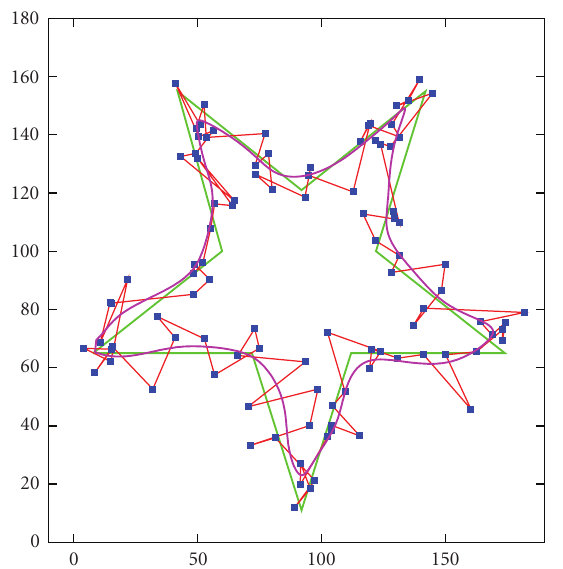
Figure 8: Recovery of the boundary of the star specified by 100 points with Gaussian noise of ν = 16. In this case, an extremely large amount of noise is added, however the algorithm is e ff ective at recovering features of the star shape. The boundary is constructed using approximate interpolation by using σ A = 1 × 10 − 6 and σ B = 4 × 10 − 4 . The recovered surface is shown as a thicker